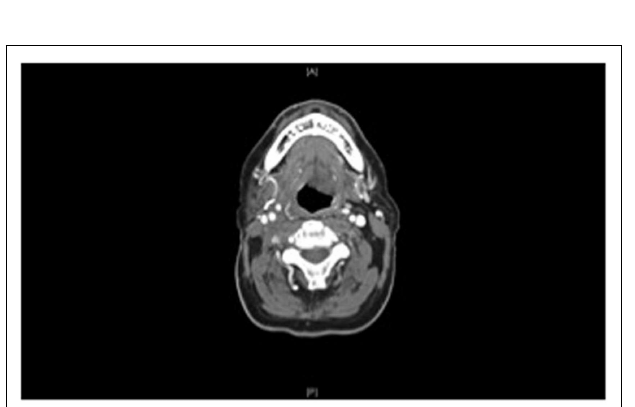
FIGURE 4 |The SRT plan isodose lines (with doses bottom right) .